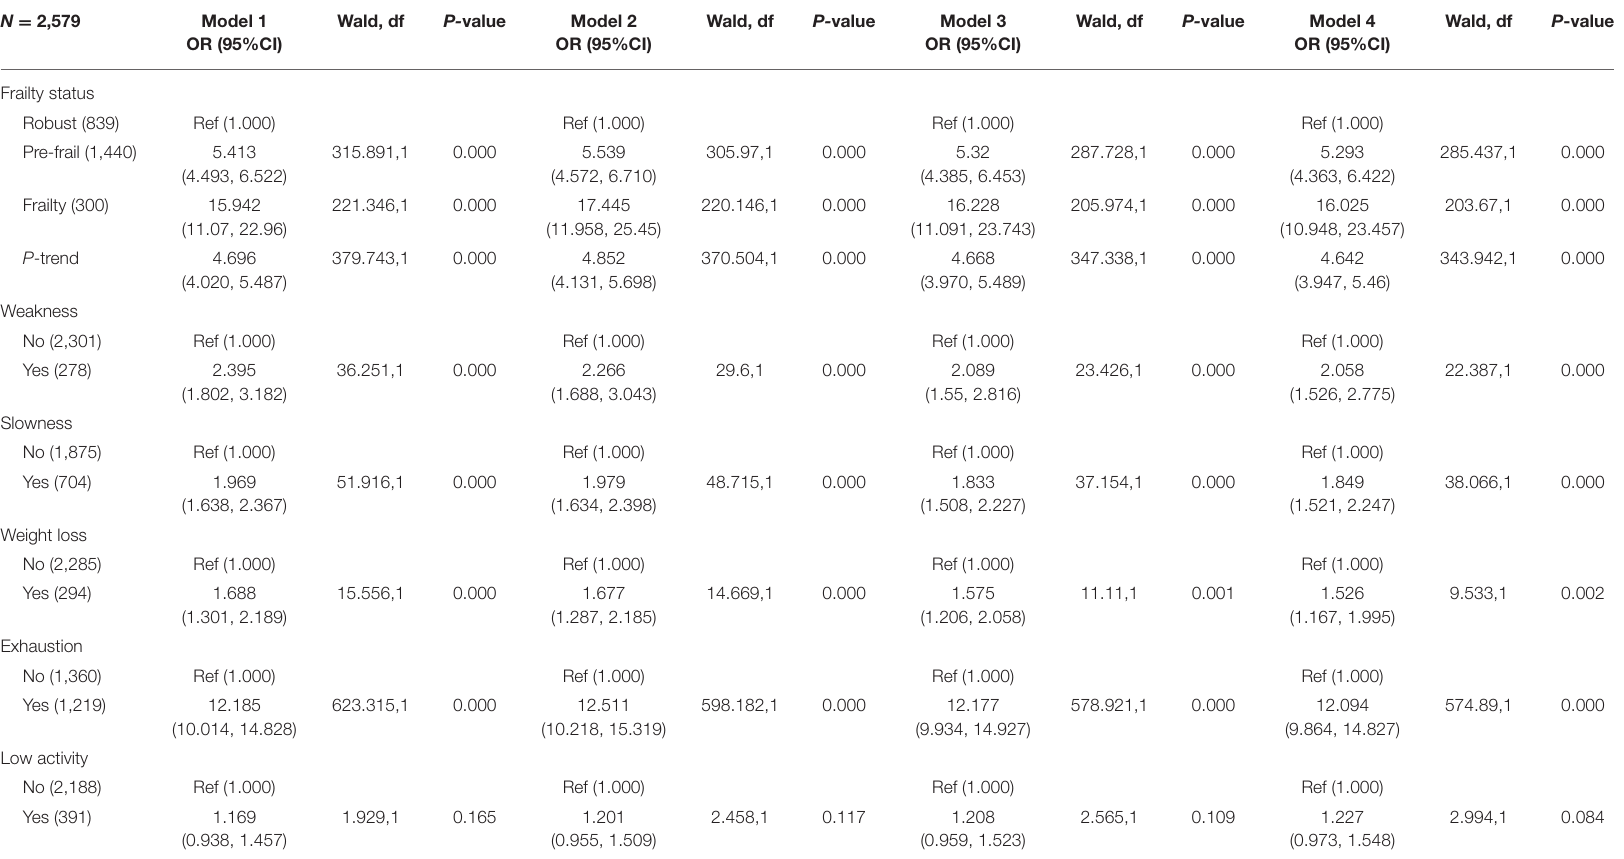
TABLE 4 | Odds ratios (ORs) and 95% confidence interval (CIs) for depressive symptoms at baseline associated with frailty and components of frailty at